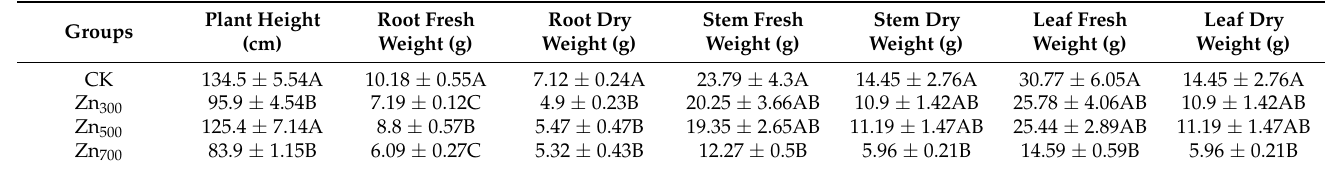
Table 2. Effects of Zn treatment on the growth and biomass of P. simonii .